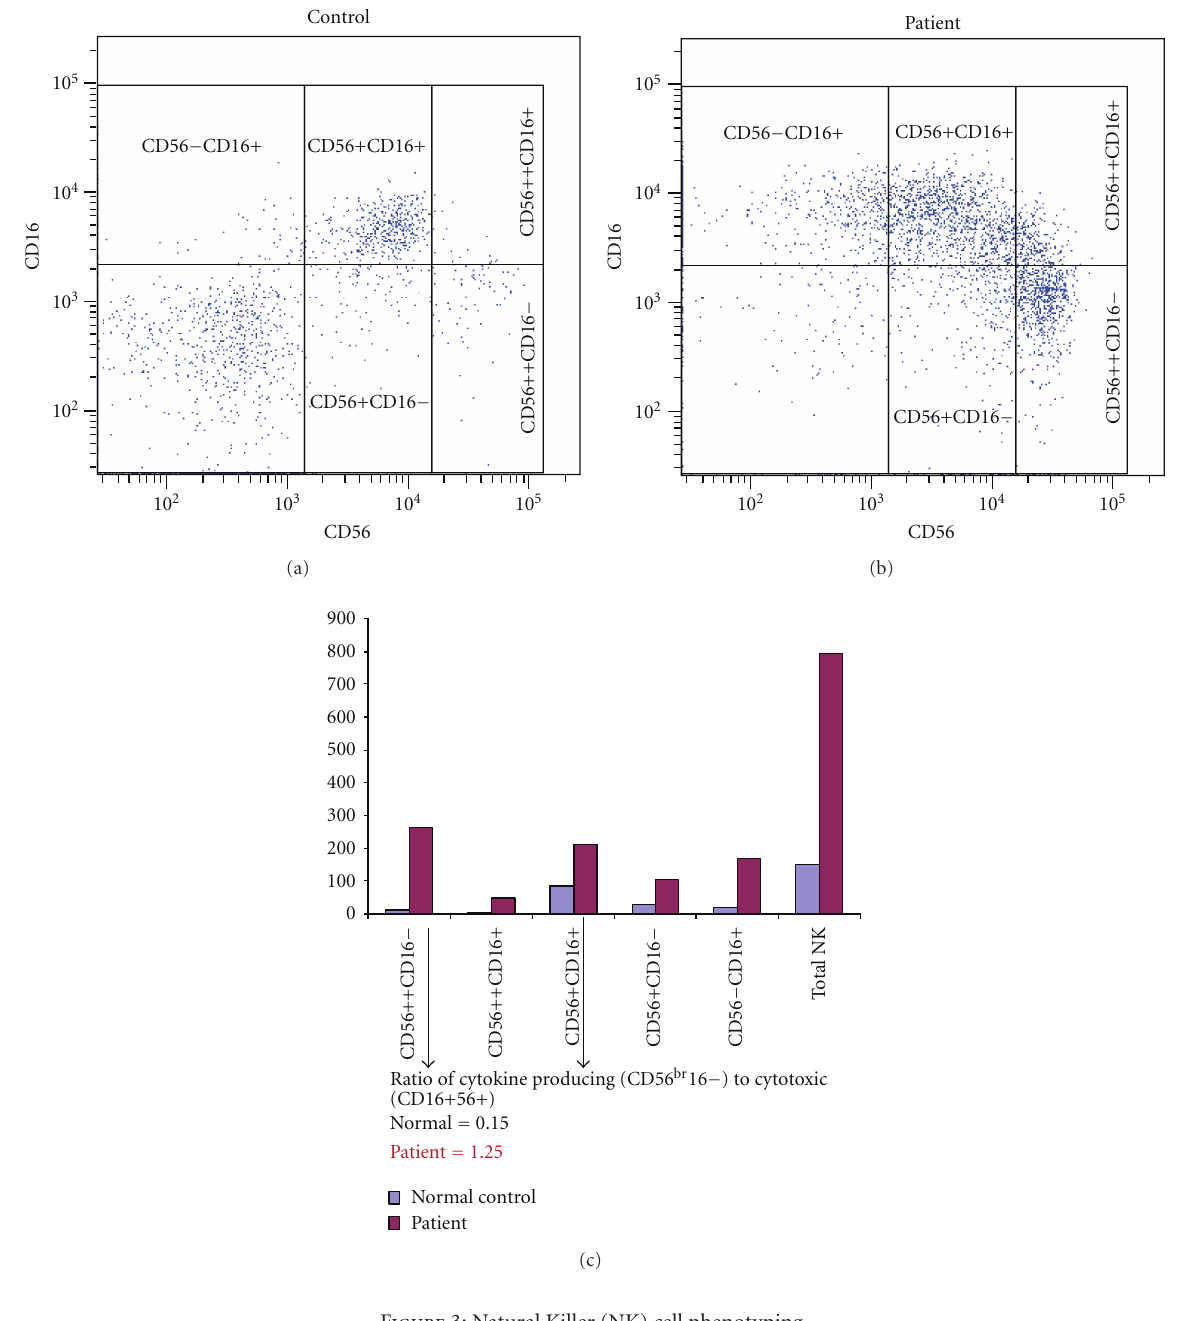
Figure 3: Natural Killer (NK) cell